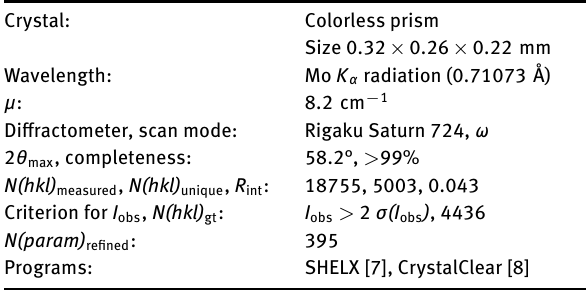
Table 1: Data collection and handling.